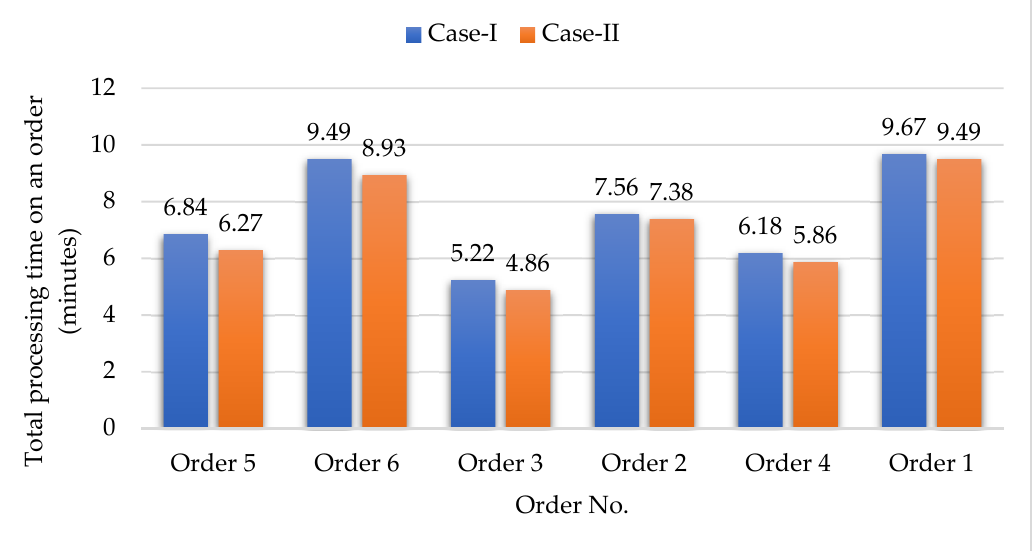
Figure 6. Comparison of the processing times for Case-I and Case-II using the FCFS rule.